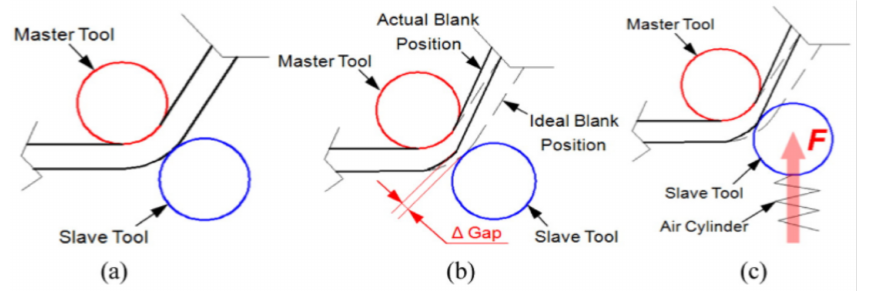
Figure 13. The E-DSIF process: ( a ) ideal position of forming tools, ( b ) loss of contact of slave tool and ( c ) supported slave tool approach to ensure a stable contact (reproduced with permission from [103]; copyright © 2015 Elsevier Ltd. All rights